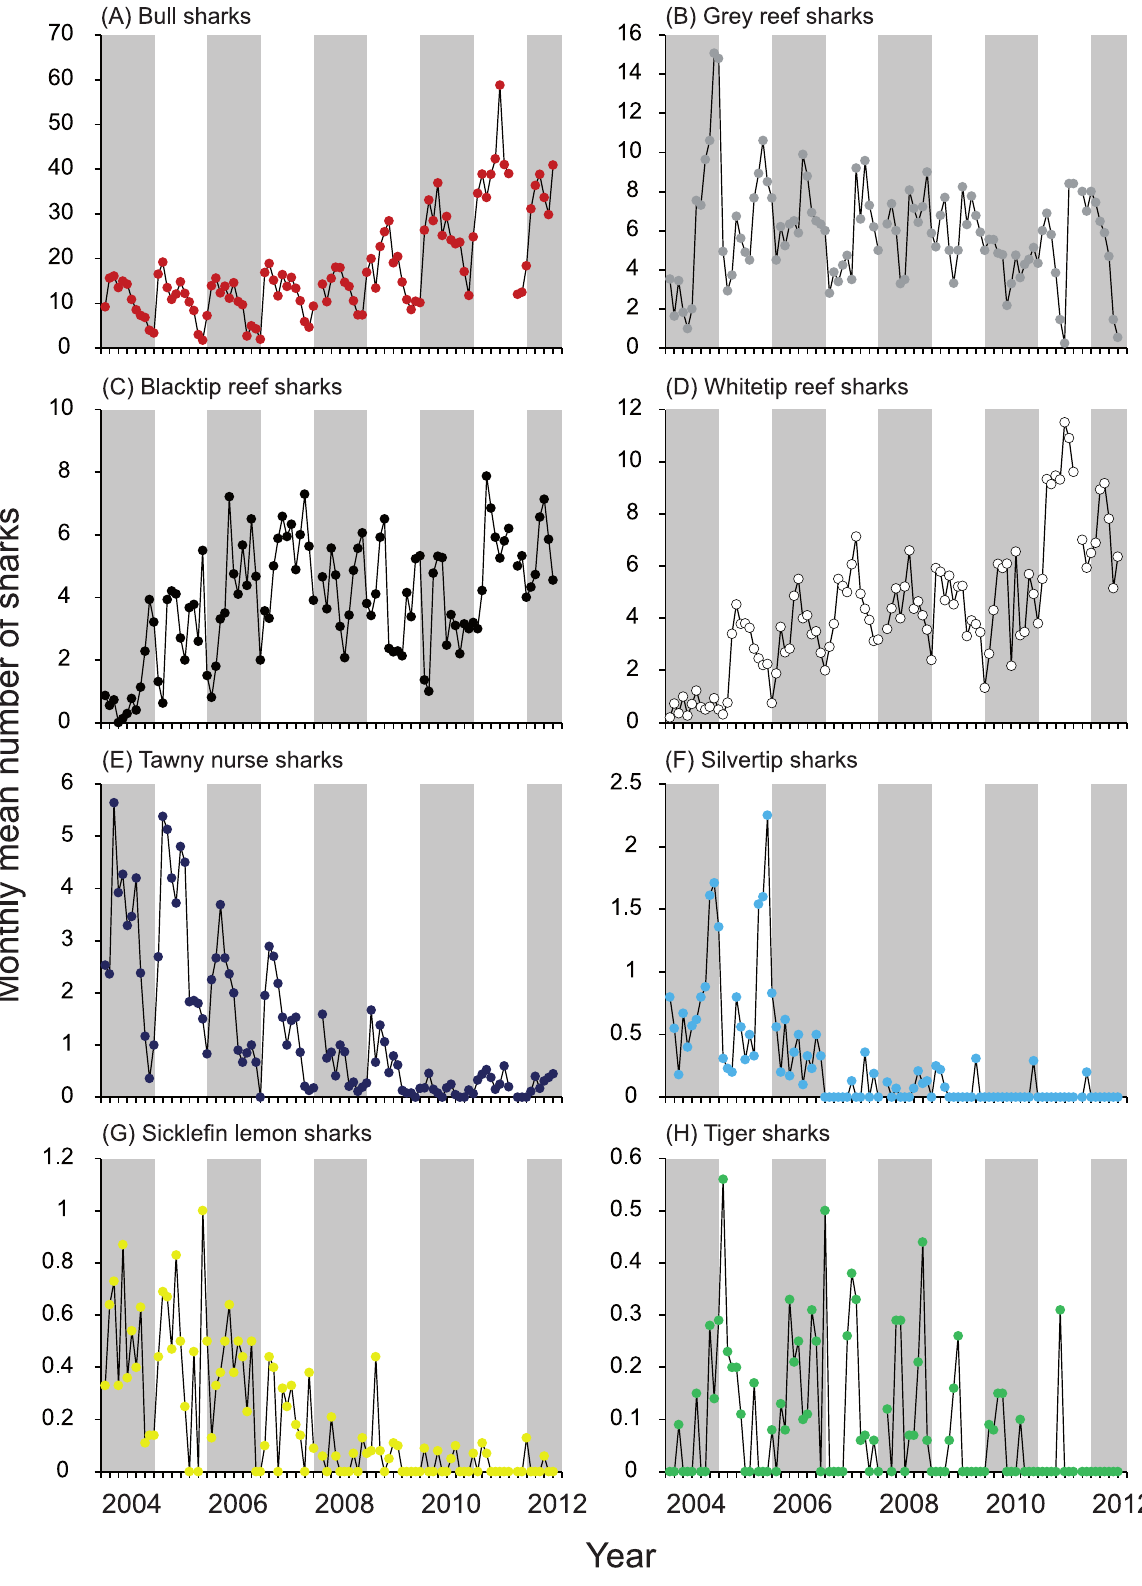
Figure 4. Monthly mean number of sharks sighted per sampling day between January 2004 and June 2012. The mean number of sharks was calculated by dividing the number of individuals counted per day by the number of sampling days in the respective month.